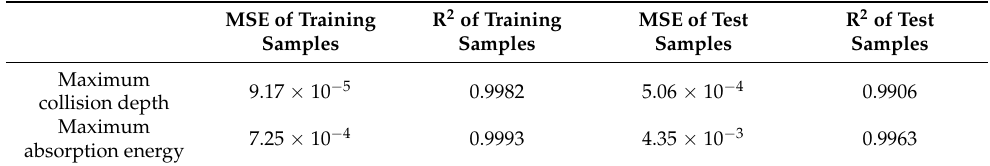
Table 6. MSE and R 2 of DPSO-BP-ANN models for training and